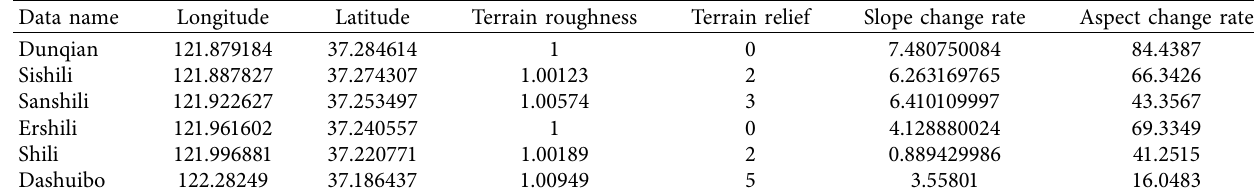
Table 2: Data extraction statistics for the ancient military road connection of Bao City.